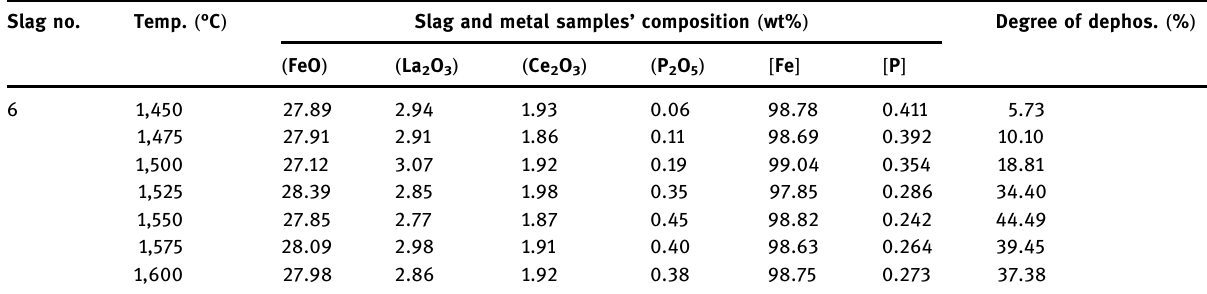
Table 2: Chemical composition of slags and metal after dephosphorization experiments at di ff erent temperatures ( wt% ) Slag no. Temp. ( °C )